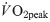
Receiver operating characteristic curve of V˙O2peak estimated by the Léger et al. and FitnessGram equations to detect obesity in boys and girls according to body mass index (BMI), waist circumference (WC), and the combination between BMI and WC.